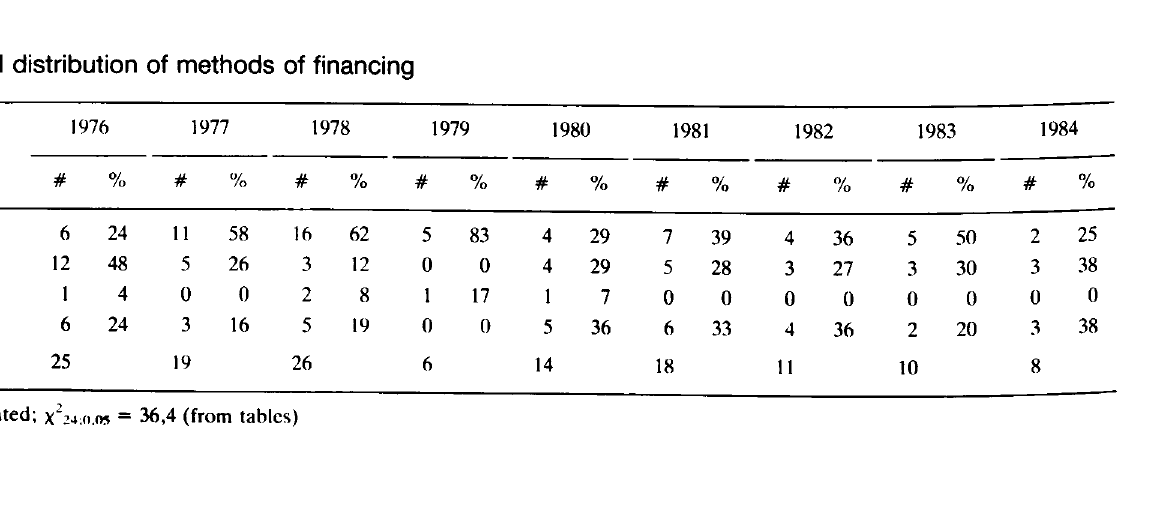
Table 3 Annual distribution of methods of